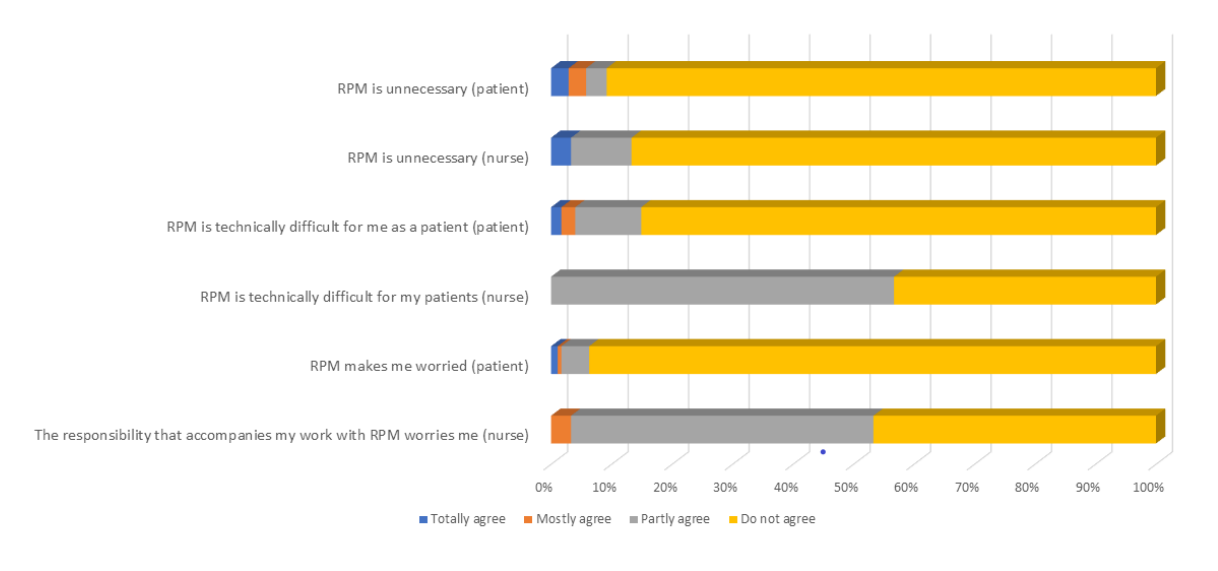
Figure 1. Negative experiences regarding remote patient monitoring (RPM) perceived by patients and